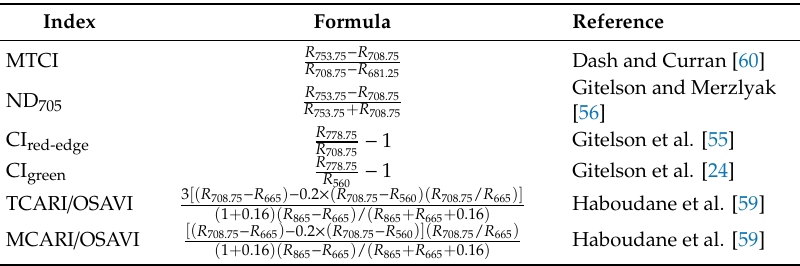
Table 4. Vegetation indices used in this study.